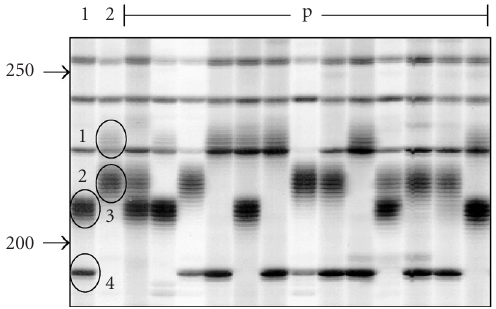
Figure 3. Close-up of autoradiograph of an RAF simple sequence repeat locus in macadamia. The first two lanes contain amplification products (Operon primer A-06) of two macadamia cultivars, and their F 1 progeny (p) are represented in the rest of the lanes. The four alleles segregating in the cross are circled and numbered. Elsewhere, on the autoradiograph, can be seen some nonstuttering, nonpolymorphic RAF markers. Approximate fragments sizes (in bp) are indicated on the left by